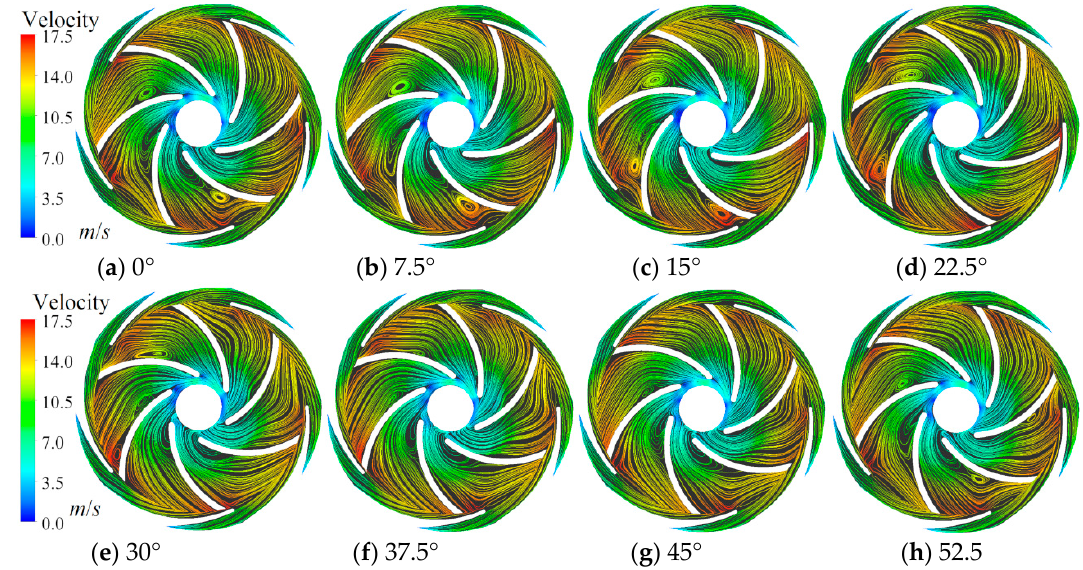
Figure 14. Evolution processes of the vortices in the stator and rotor cascade during a 1 / 6 period of impeller rotation under condition 1.4 Q d .